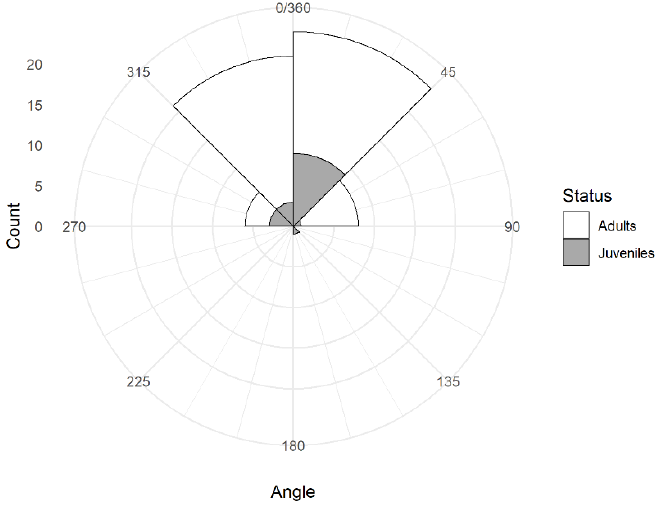
Table 1. Statistically significant departures from the null expectation that average head orientation is equal to 0° for each status of Florida scrub-jay sentinels ( n = 60).